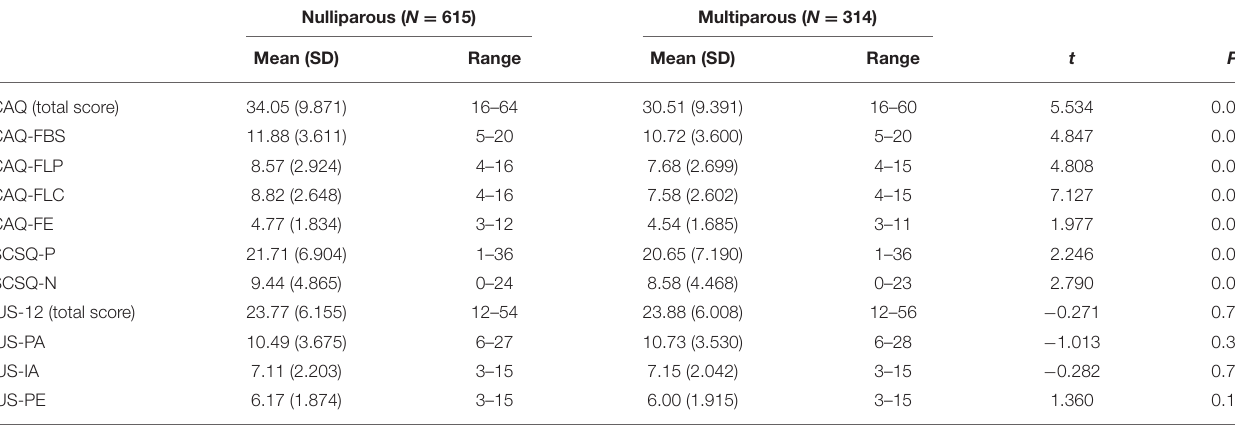
TABLE 3 | Mean differences between nulliparous and multiparous women across CAQ, SCSQ, and